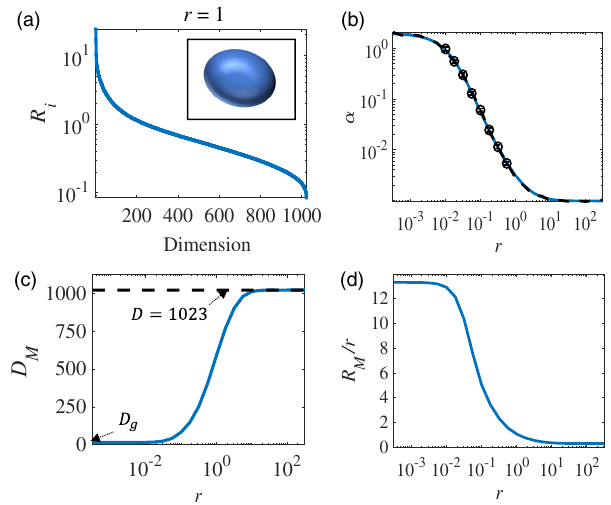
FIG. 8. Ellipsoids with radii computed from realistic image data. (a) SVD spectrum R , taken from the readout layer of i GoogLeNet from a class of ImageNet images with N ¼ 1024 and D ¼ 1023 . The radii are scaled by a factor r : R 0 ¼ rR i for i (b) Classification capacity as a function of r : full mean-field theory capacity (blue lines); approximation of the capacity as that of a ball with R and D from the theory for ellipsoids (black M M dashed lines); simulation capacity (circles), averaged over 5 repetitions, measured with 50 random dichotomies per each repetition. (c) Manifold dimension as a function of r . (d) Manifold =r as a function of r radius relative to the scaling factor r , R M